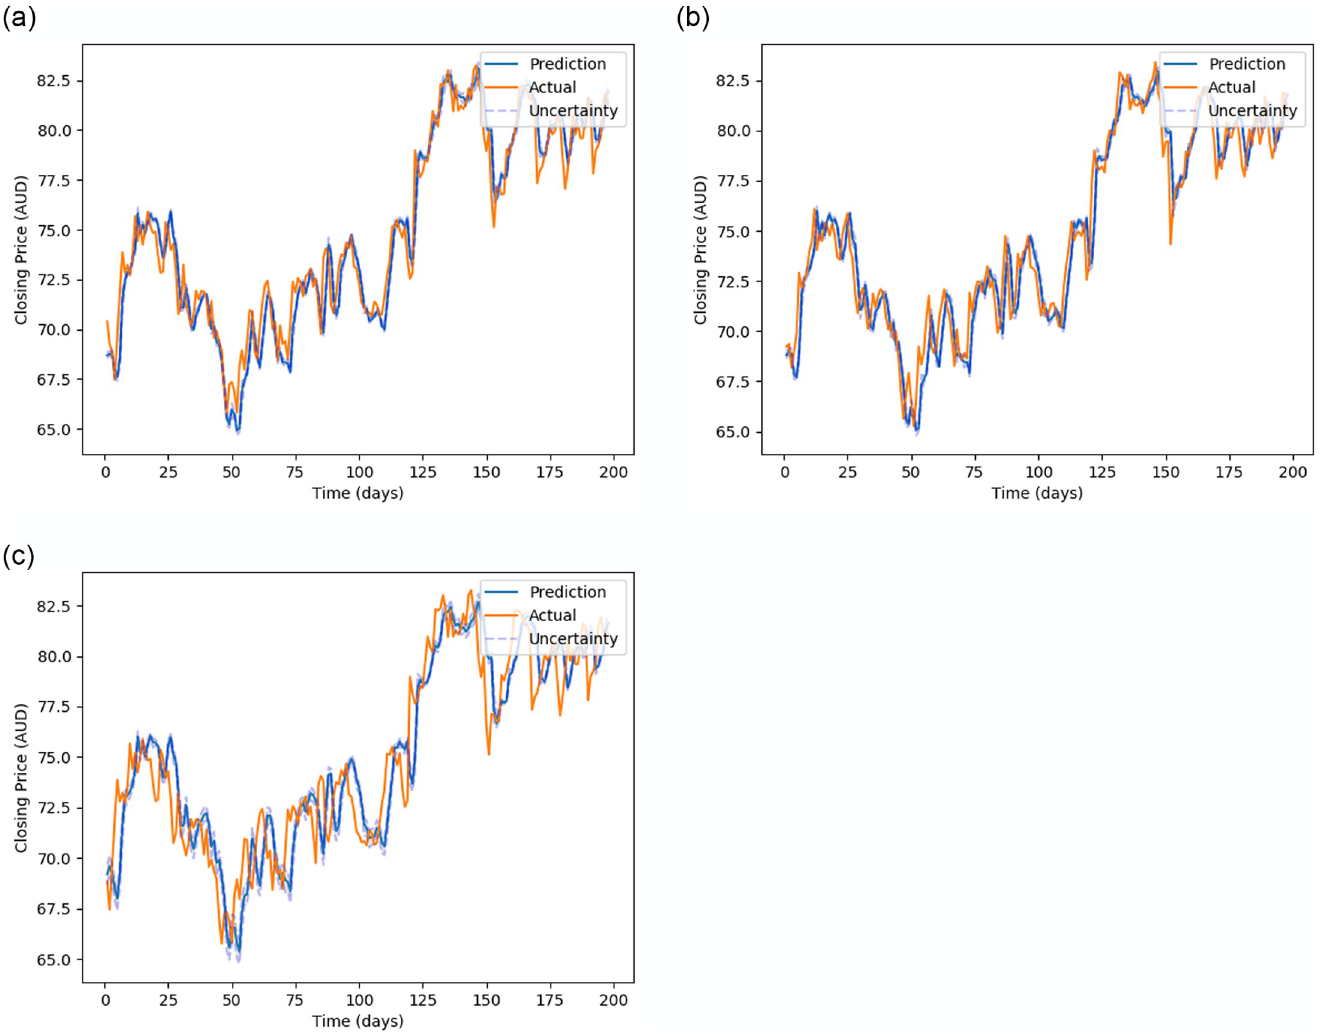
Fig 7. Prediction and uncertainty (shaded region) for test data of stock